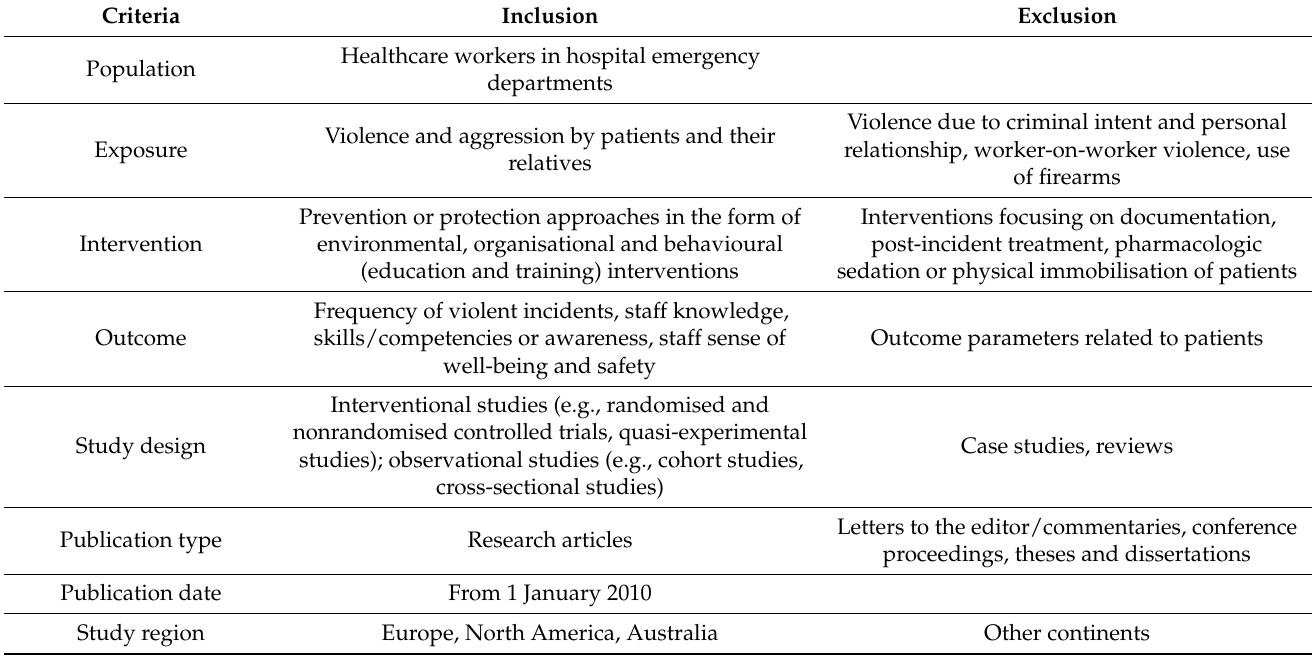
Table 1. Eligibility criteria for the screening and selection of